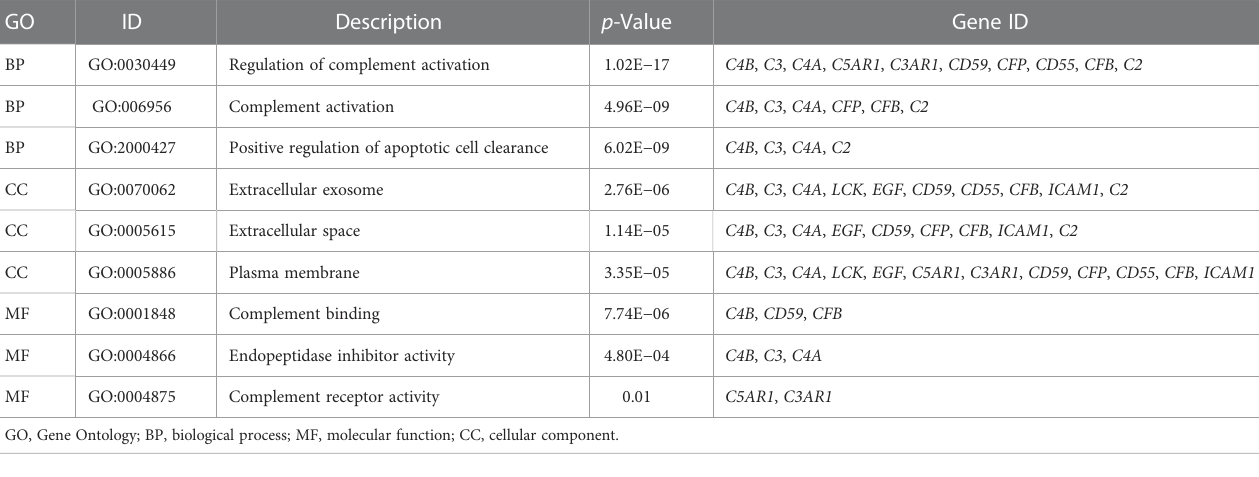
TABLE 2 GO pathway enrichment